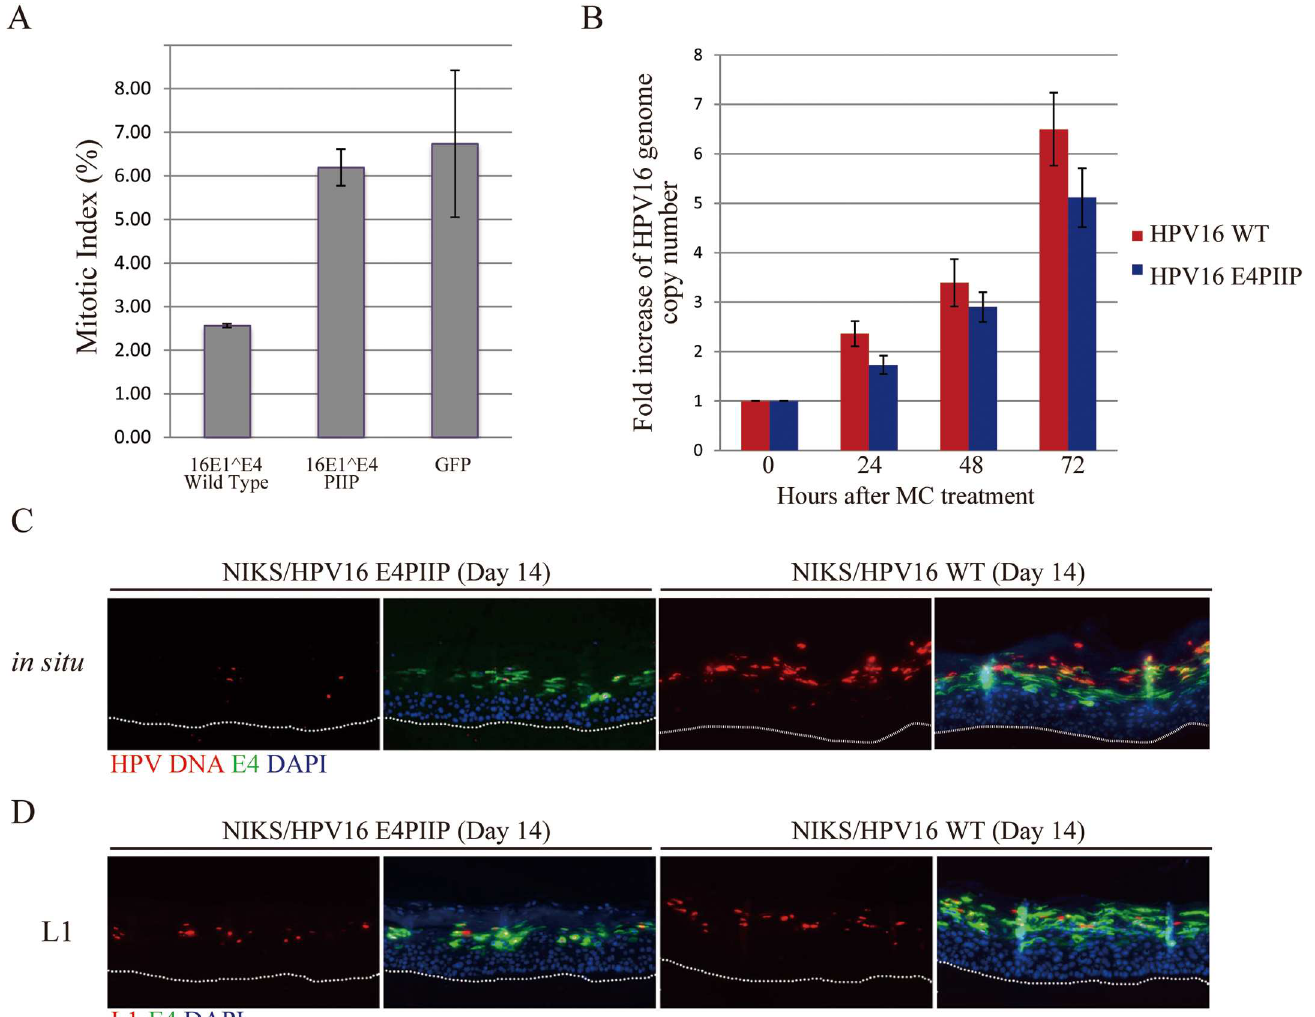
Fig 4. The G2 arrestfunction of HPV16 E1^E4 contributes to viral genome amplification and L1 expression. (A) Mitotic index of Cos-7 cells expressingeither the HPV16 WT E1^E4 protein, the E1^E4 PIIP mutant that is defective in G2 arrest function, or a control protein (GFP) that does not inhibit cell cycle progression. The E1^E4 PIIP mutant has lost its ability to prevent mitotic entry when comparedto WT 16 E1^E4. (B) HPV16 WT or PIIP mutant genome-containingNIKS were suspendedin 1.5% methylcellulose(MC) in order to inducedifferentiation, and were harvestedat 0h, 24h, 48h and72h. Genomic DNA copy numbersweremeasured by qPCR.The resultsare presentedas fold-increasein HPV16genomecopynumberrelativeto the zero hourtime point. A reductionin genomeamplificationsuccesswas noticeableat all time points. (C & D) Viralgenomeamplification andL1 expression wereexaminedat day14 post-differentiationby fluorescence in situ hybridization (FISH signalshownin red in C) andindirectimmunofluorescence(L1 stainingshownin red in D) in raft tissuesderivedfrom NIKS cellsharboringeitherthe HPV16WT or E4KO genomes.Viralgenome amplification andL1 expressionwerecompromised in the PIIP mutant. The dottedlines indicatethe positionof the basallayer.Imageswerecaptured usinga 10x objective.